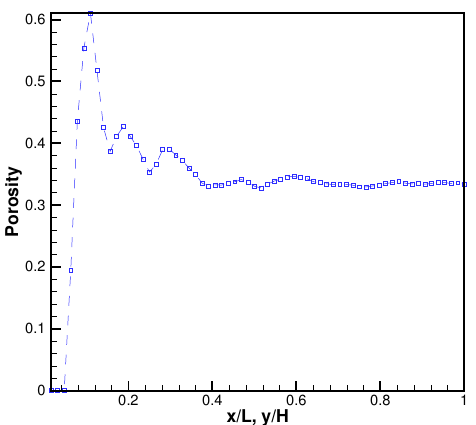
Figure 3. Porosity as a function of the domain size. L is the length of the entire micromodel, while H is its width; x refers to the distance to the left boundary, and y is the distance to the bottom boundary. For each point shown above, the same scaling was applied to x and y, i.e., x/L = y/H.